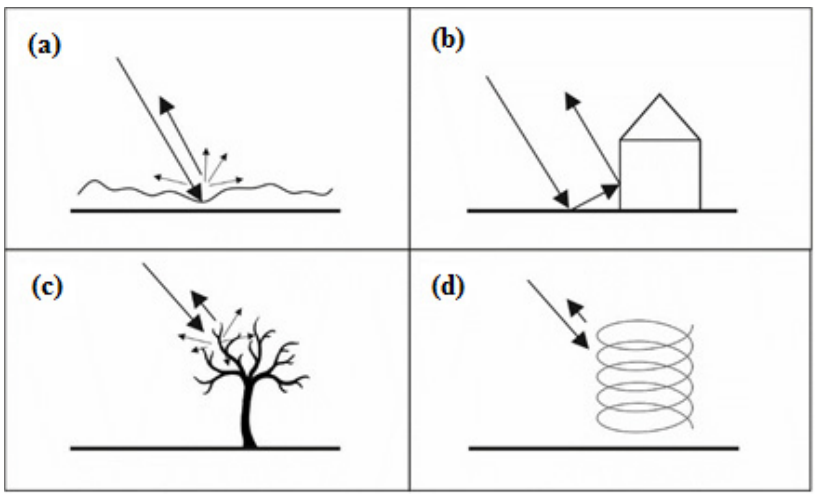
Figure 1. Basic scattering types ( a )—single-bounce, ( b )—double-bounce, ( c )—volume scattering, ( d )—helix scattering).